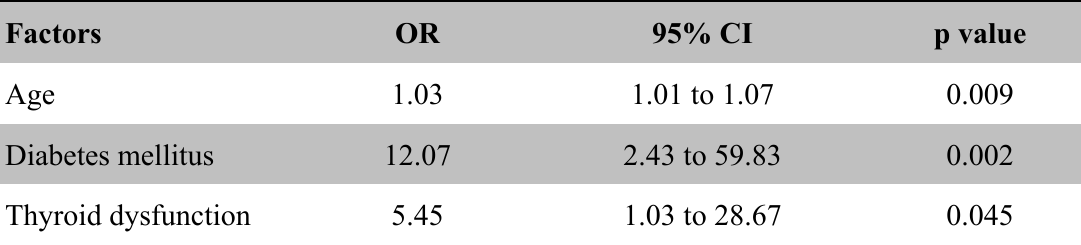
Table 3: Multivariate logistic regression analysis